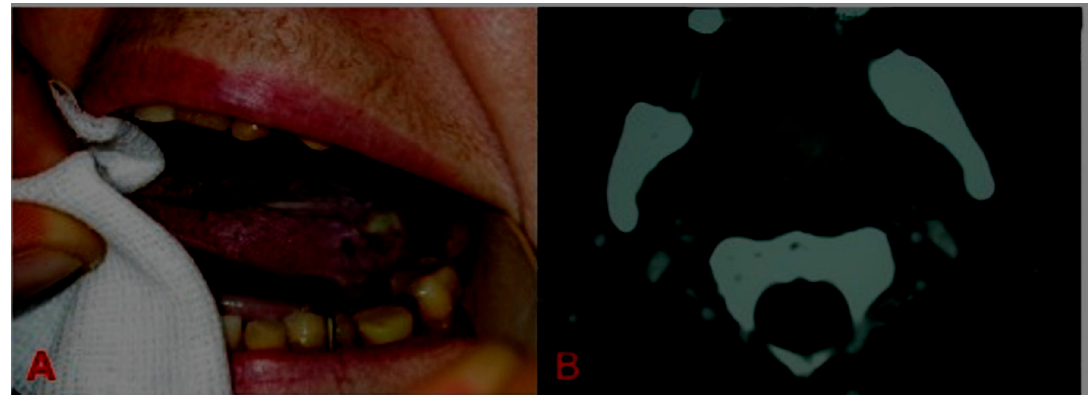
Figure 3. Case 2: A 67-year-old Caucasian female affected by a SCC of the tongue staged as pT4aN1 who underwent total glossectomy en-bloc with left MRND and right SND (I-III), and contemporary reconstruction using the rectus abdominis free flap. ( A ) Pre-operative intraoral view of the lesion; ( B ) pre-operative axial CT scan, with contrast showing a large lesion involving the whole left hemitongue and the anterior and middle third of the right one.